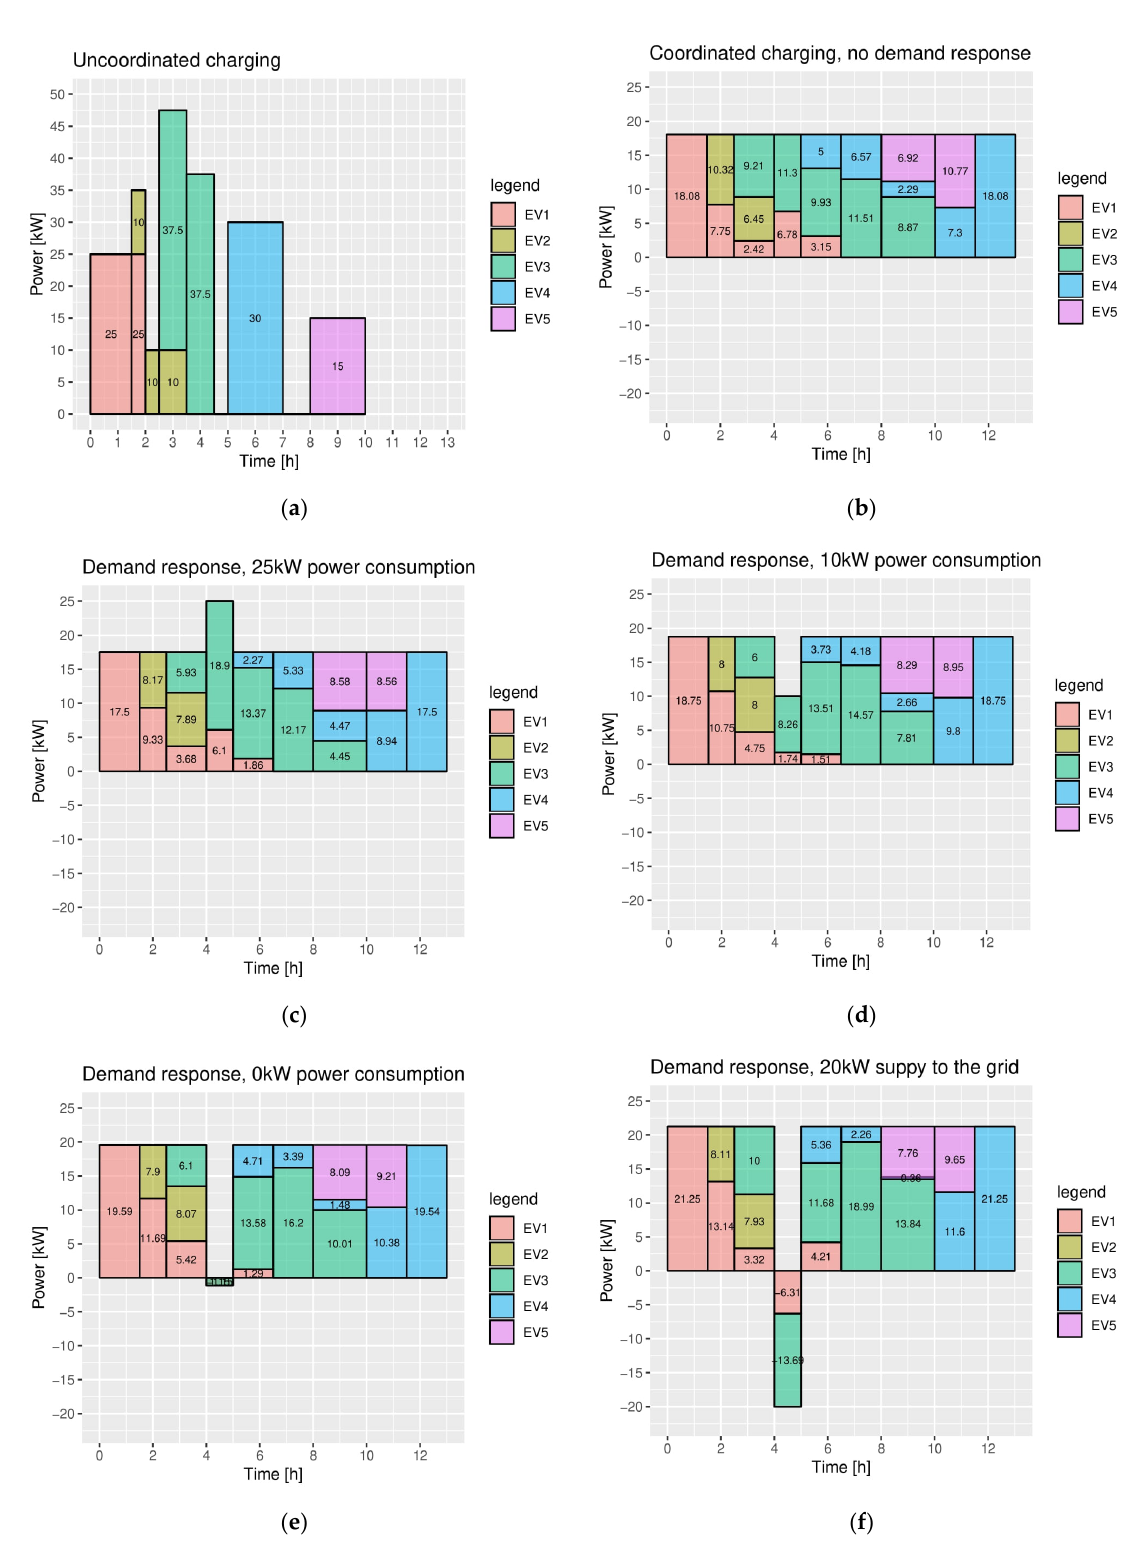
Figure 6. Example of the proposed algorithm’s DR capabilities in a single selected scenario, where the DR event takes place from 4 to 5 h. ( a ) Uncoordinated charging without DR signals. ( b ) Coordinated charging without DR signals. ( c ) Increasing the parking lot load to 25 kW during DR event. ( d ) Load reduction to 10 kW during DR event. ( e ) Load reduction to 0 kW during DR event. ( f ) Supplying 20 kW to the grid during DR